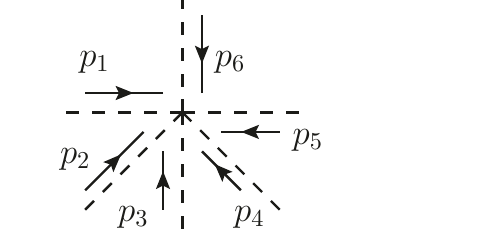
Figure 3. The 6-pt interaction vertex required by imposing the Adler’s zero condition on M 6 : P 2 =f 2 135 (cid:0)